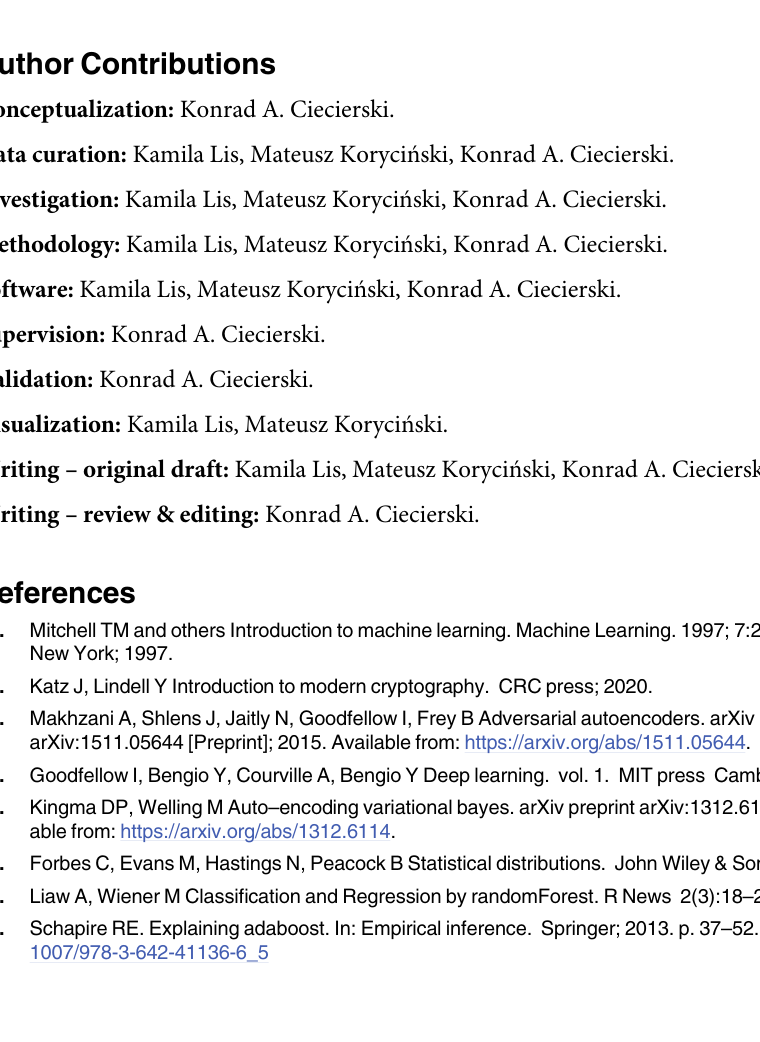
S3 Table. Normal discriminator. S4 Table. Categorical discriminator. S5 Table. Classification results for 2-class subsets drawn from CIFAR100 dataset. S6 Table. Classification results for 3-class subsets drawn from CIFAR100 dataset. S7 Table. Classification results for 4-class subsets drawn from CIFAR100 dataset. S8 Table. Masked images